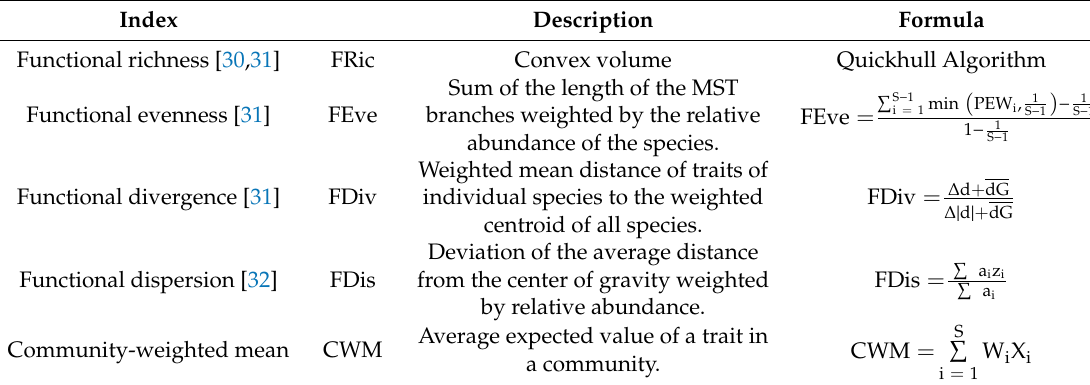
Table 1. Descriptions and formulas used to calculate the functional diversity indices are modified from Schleuter et al.